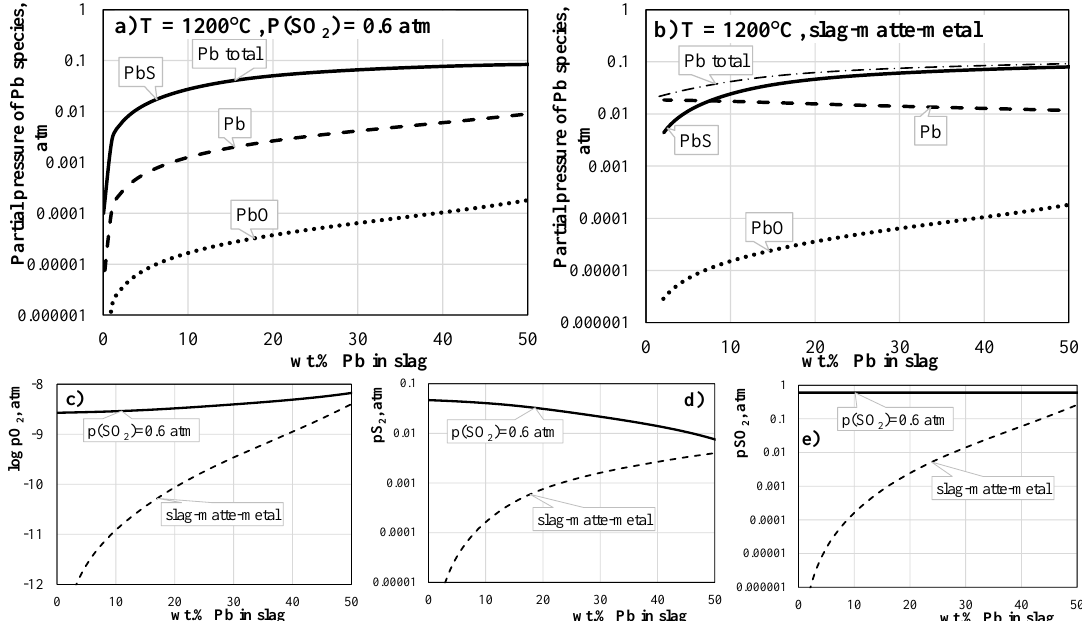
Figure 1. Calculated equilibrium partial pressures of Pb gas species at 1200 °C in the Pb-Fe-O-S-Si system, a ) p (SO 2 ) = 0.6 atm, slag – matte – tridymite, b ) at lower p (SO 2 ), slag – matte – metal – tridymite, and associated c ) pO 2 , atm., d ) pS 2 , atm., e ) pSO 2 , atm., using the FactSage internal thermodynamic database [4,5]. Note: in a ) Pb (total) overlaps with PbS.